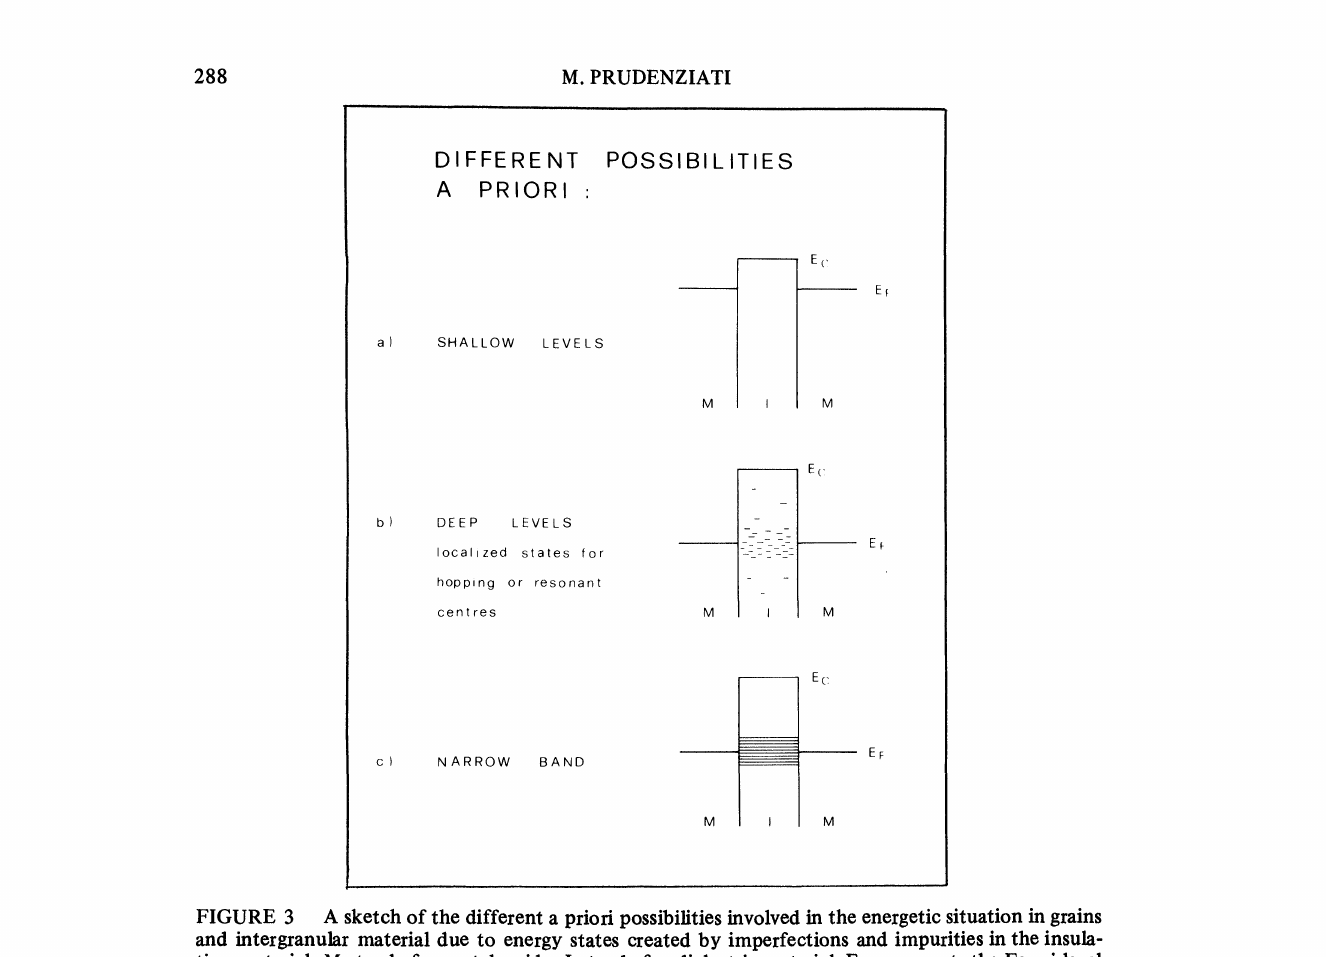
A sketch of the different a priori possibilities involved in the energetic situation in grains and intergranular material due to energy states created by imperfections and impurities in the insula- ting material. M stands for metal oxide, stands for dielectric material, E F represents the Fermi level of the system and E c the conduction band of the dielectric material. The electrical consequences of these different situations are discussed in the